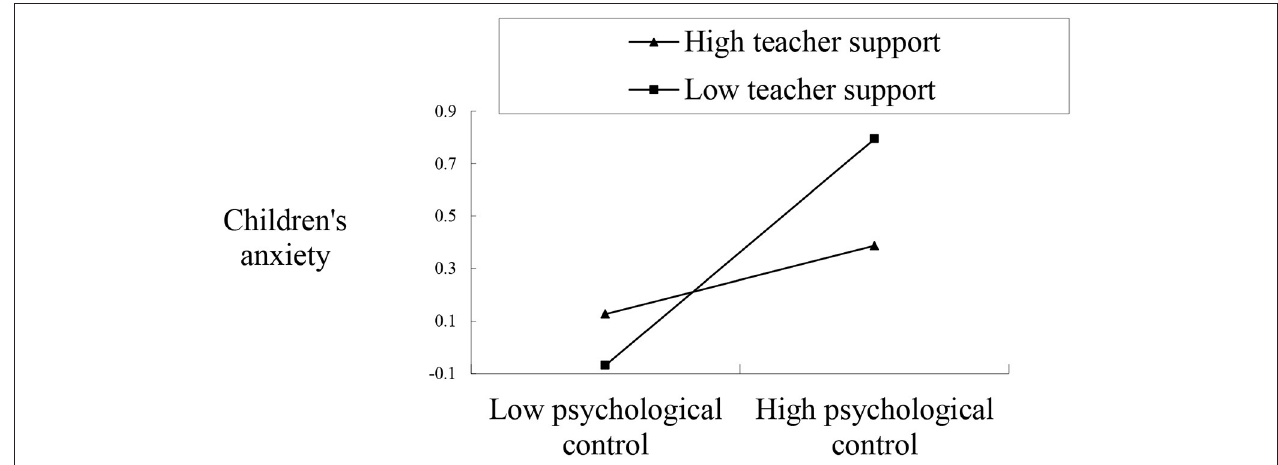
FIGURE 2 | Interaction between maternal psychological control and teacher support in predicting anxiety in children with only a migrant father.